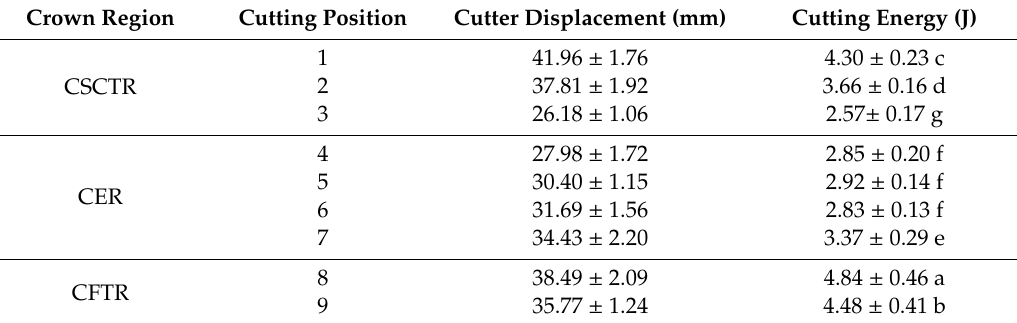
Table 1. The values of cutting energy and corresponding cutting